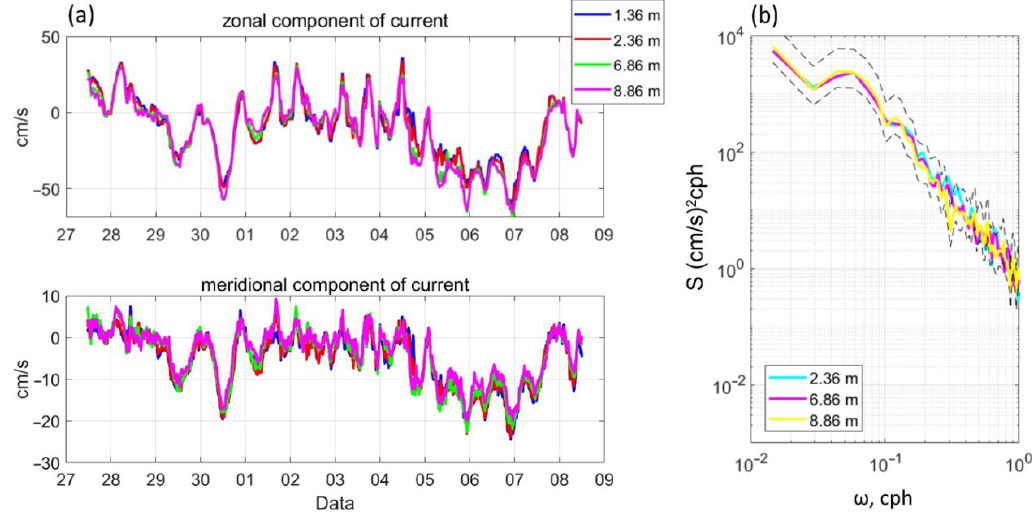
Figure 9. ( a ) Variability of the velocity components on 27 September–8 October 2020. ( b ) Frequency spectra according to the data of zonal velocity component at several depths. Dashed lines show the 95% confidence interval.